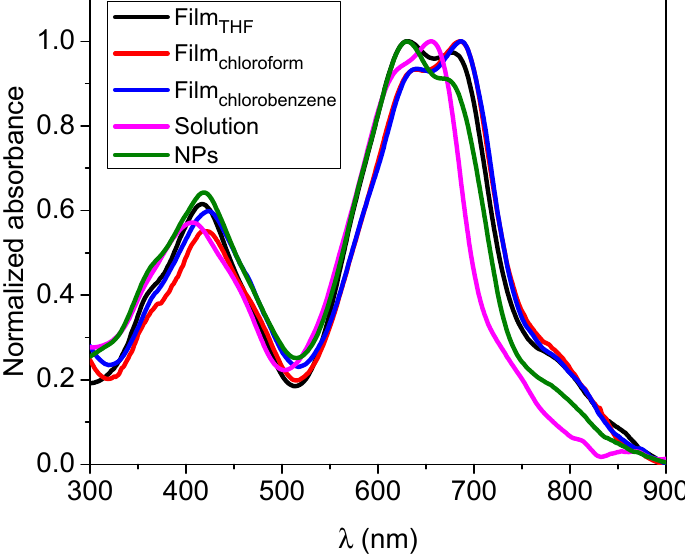
Figure 10. Normalized absorbance of PFDPP-1 in films, solution, and NPs.